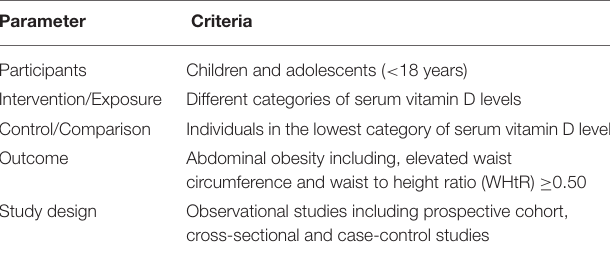
TABLE 1 | Population, Intervention, Comparison, Outcomes and Study (PICOS) criteria for inclusion of studies.